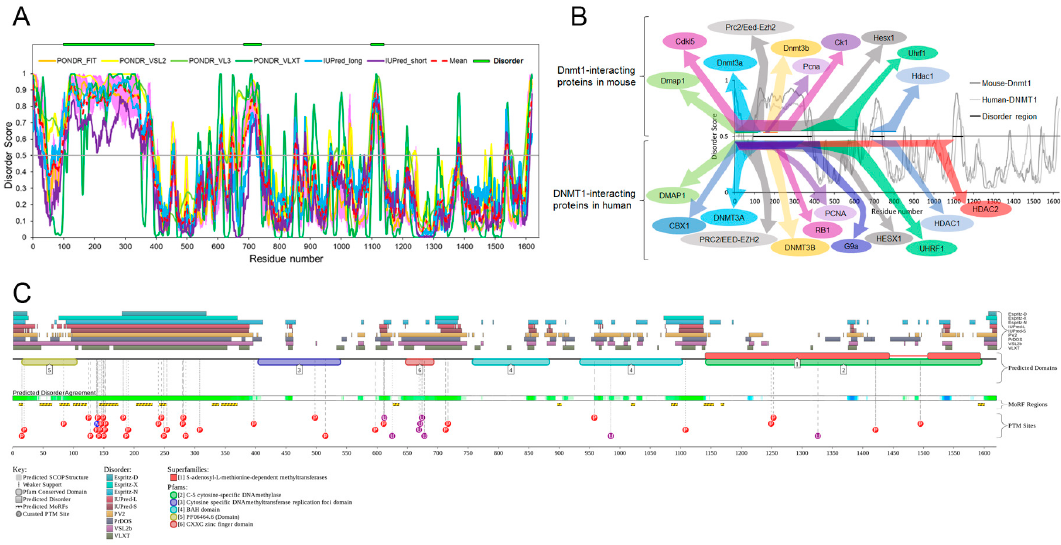
Figure 8. Functional disorder in mouse DNA methyltransferase (cytosine-5) 1 (DNMT1) protein (UniProt ID: P13864). ( A ) Disorder profiles generated by PONDR ® FIT, PONDR ® VSL2, PONDR ® VL3, PONDR ® VLXT, IUPred_long, and IUPred_short and a consensus disorder profile. Detailed statistical information is listed in supplemental Table S1. ( B ) Disorder-related interactivity analysis. A consensus disorder profile is shown in the centre of the figure along with 12 mouse proteins and 14 human proteins physically interact with the different disorder regions of DNMT1. ( C ) Intrinsic disorder propensity and some important disorder-related functional information generated the D 2 P 2